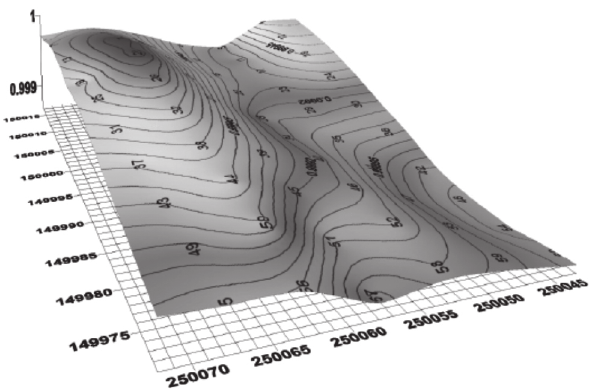
(2) Figura 1. Mapa planialtimétrico da área experimental,